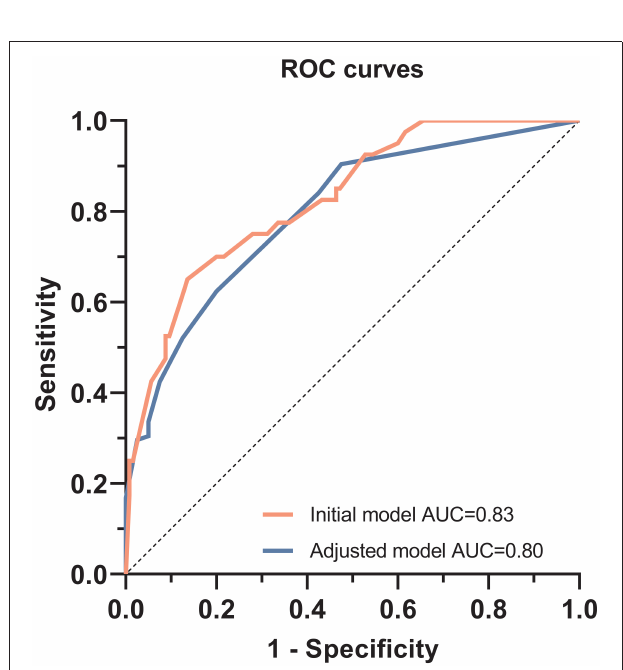
FIGURE 5 | Receiver operating characteristic curves to evaluate the predictive value of the multivariable logistic regression model for predicting proteinuria in TG patients. For the initial multivariable logistic regression model, the area under the curve (AUC) was 0.83 (95% CI, 0.76–0.90, P < 0.001). After bootstrap replication, AUC was 0.80 (95% CI, 0.72–0.87, P < 0.001).